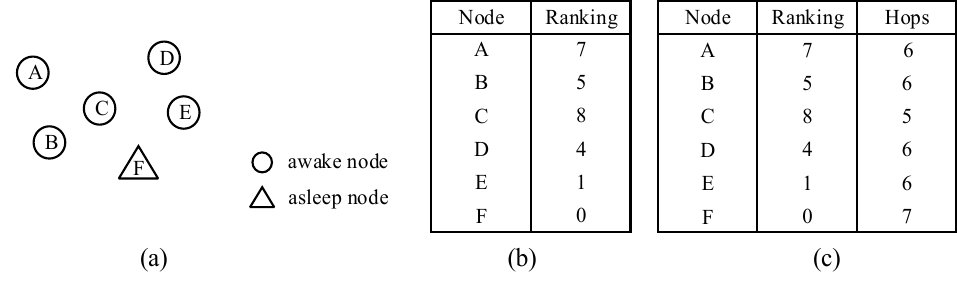
Figure 4. Sleep scheduling of CKN and GSS: ( a ) neighbors of node C; ( b ) ranking of CKN; ( c ) ranking of GSS of GSS [55].